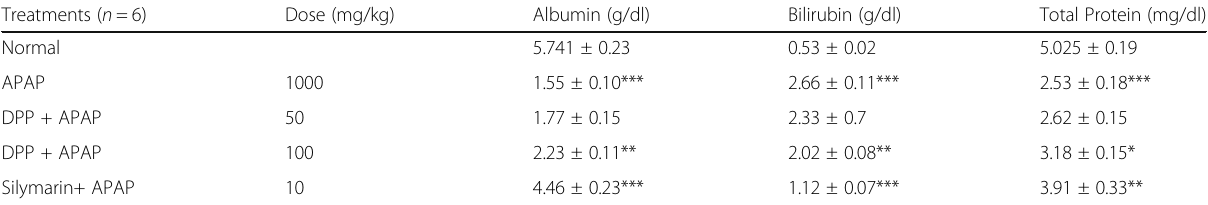
Table 5 Effect of DPP on APAP-intoxicated rats serum albumin, bilirubin, and total protein Treatments ( n = 6)